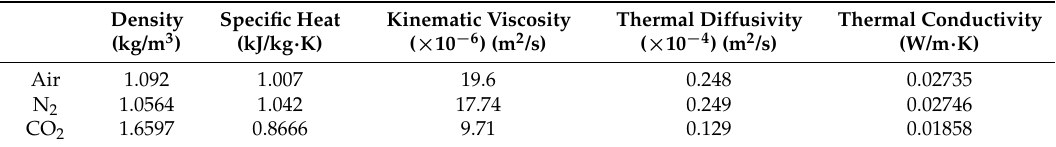
Figure 5. The output characteristics of the accelerometer as a function of the gas medium with respect to: ( a ) acceleration and ( b ) frequency. Table 1. The gas medium properties at 50 °C [20].